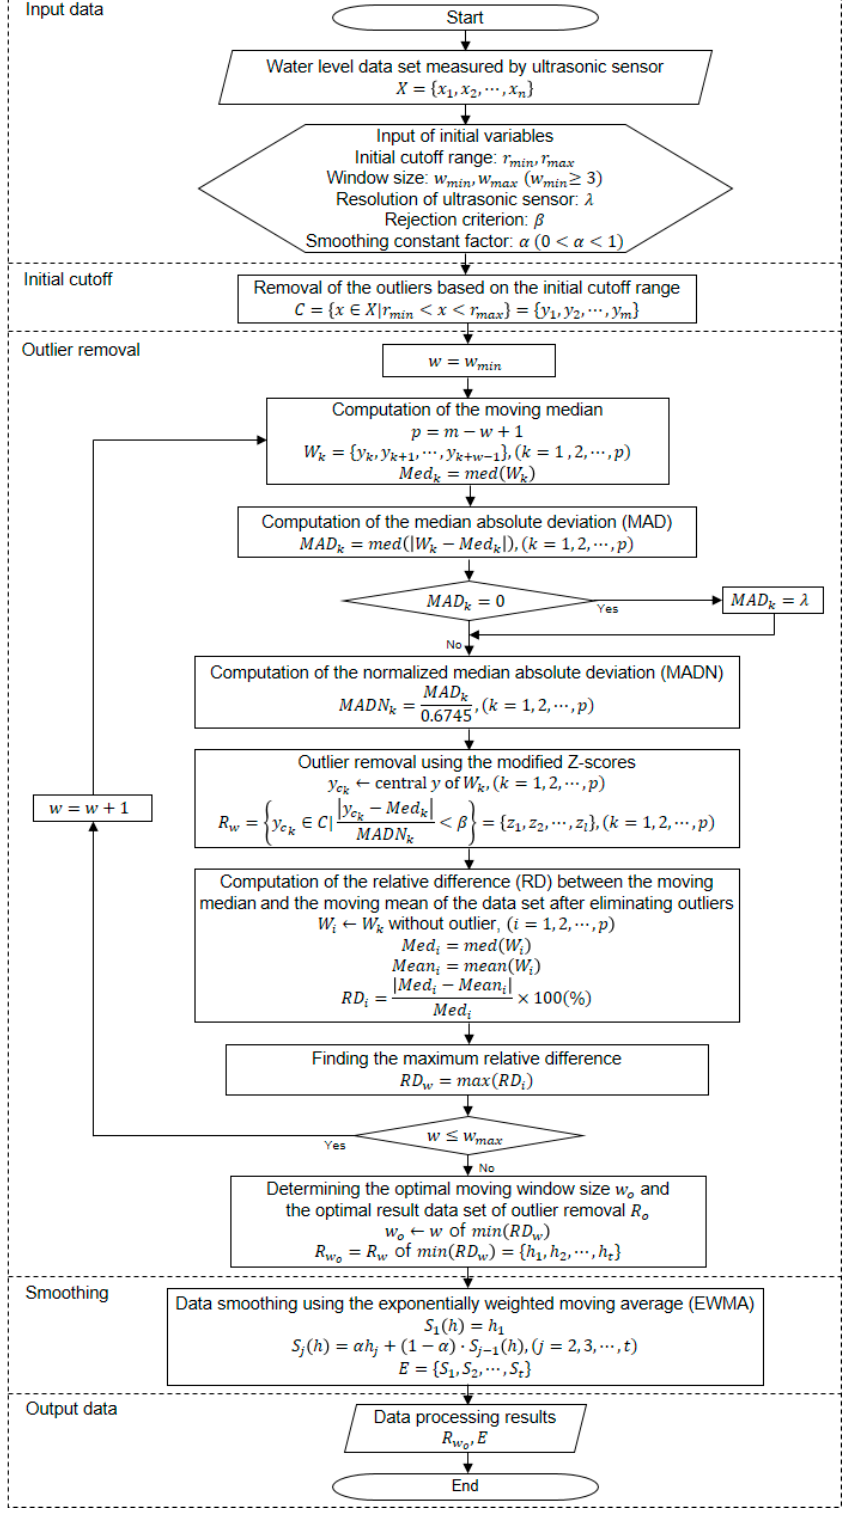
Figure 4. Flow chart of data processing for the outlier removal and the data smoothing for water level data measured by ultrasonic sensor.